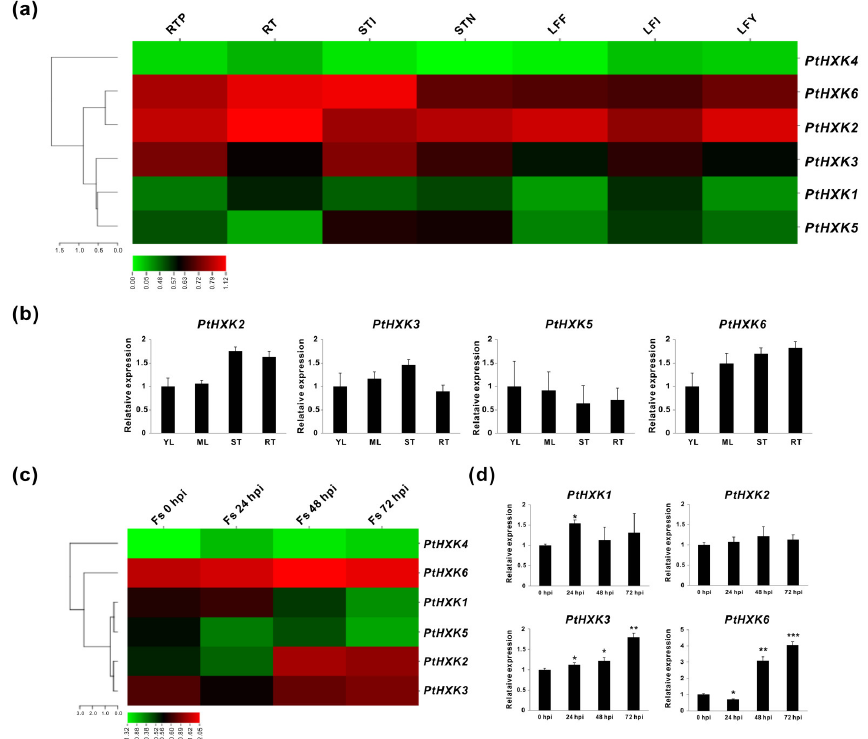
Figure 5. Transcriptomic and expression profiles of PtHXKs in vegetative tissues and roots challenged by F. solani (Fs). ( a ) The heatmap shows the transcript in vegetative tissues of P. trichocarpa . ( b ) The qRT-PCR evaluation shows the tissue-specific expression of PtHXKs . ( c ) The heatmap shows the transcriptomic profile of PtHXK isogenes in Fs infected roots (0, 24, 48, and 72 h of post-inoculation, hpi). ( d ) Validation of responsive PtHXKs compared to the control (0 hpi) by qRT-PCR. The RNA-seq data were given in the Log10 of the fragments per kilobase per million reads (FPKM) expression values. At least three independent biological replicates were conducted for qRT-PCR analyses. Pt β Actin , PtUBIC , and PtEF- α 1 were used as the internal control. Data represent mean values standard error ( ± SE) of at least three independent biological replicates. Asterisks indicate significant differences relative to the control using the Student’s t -test: *** p < 0.001, ** p < 0.01, and * p <